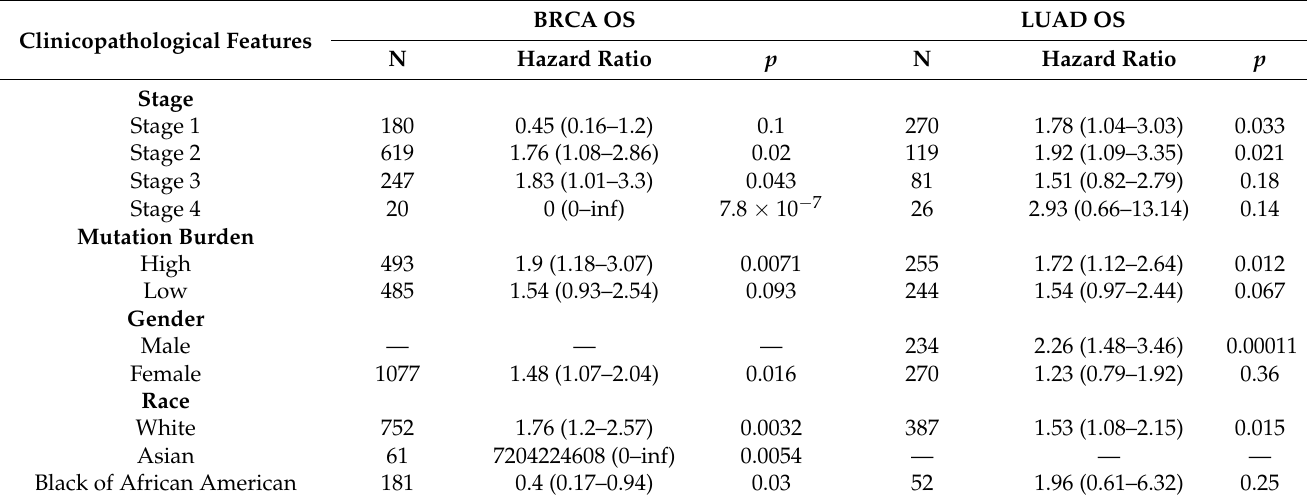
Table 4. Correlation of KRAS with BRCA and LUAD OS with different clinicopathological